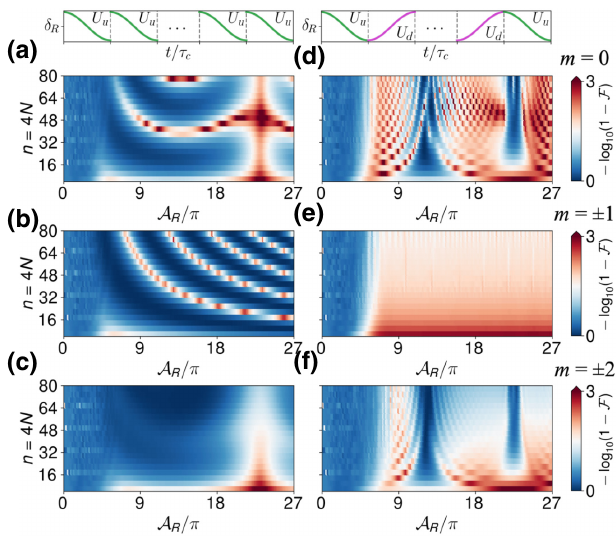
FIG. 7. Numerical results of gate infidelity 1 − F for the tra- ditional ˜ U ( 4 N ) (left panels) and balanced chirp-alternating ˜ U ( 4 N ) uu uddu (right panels) controls. With F = F ( 4 N ) and m = 0 (a),(d), m = m ± 1 (b),(e), m = ± 2 (c),(f). The two-photon detuning profiles are illustrated on top of (a),(d). Additional parameters for the simulations are according to Sec. III